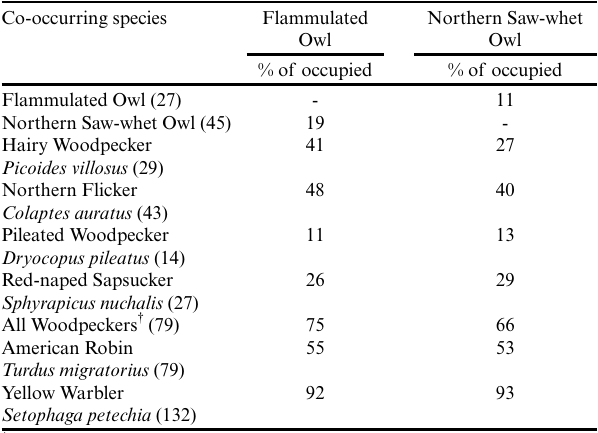
Table 1 . Co-occurrence of sympatric cavity-nesting owls and (1) woodpeckers and (2) two passerines species used as controls in the Boise National Forest, Idaho, USA. Number of point-count locations (of 150) where species were detected is shown in parentheses. Table values represent the percentage of point-count locations occupied by Flammulated Owls ( Psiloscops flammeolus ) and Northern Saw-whet Owls ( Aegolius acadicus ) that were also occupied by sympatric cavity-nesting owls, woodpeckers, or